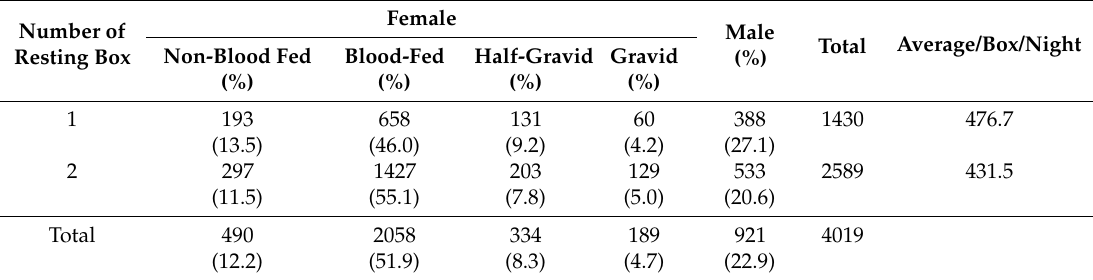
Table 5. Numbers of Cx. quinquefasciatus found in one and two resting boxes without